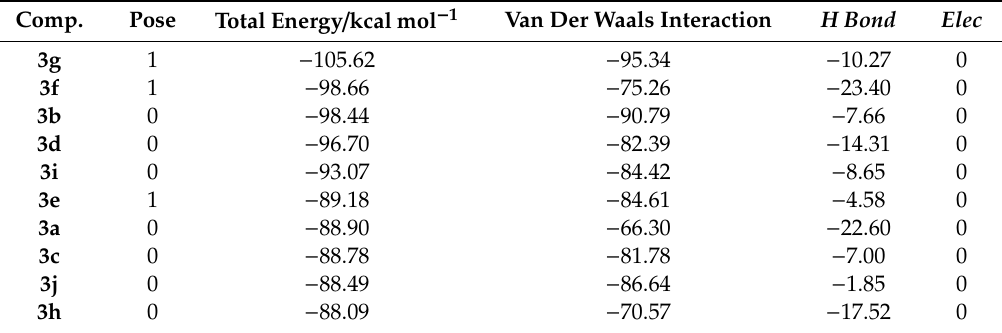
Table 4. Docking scores for fluorinated pyrazoles in interaction with PDE5.